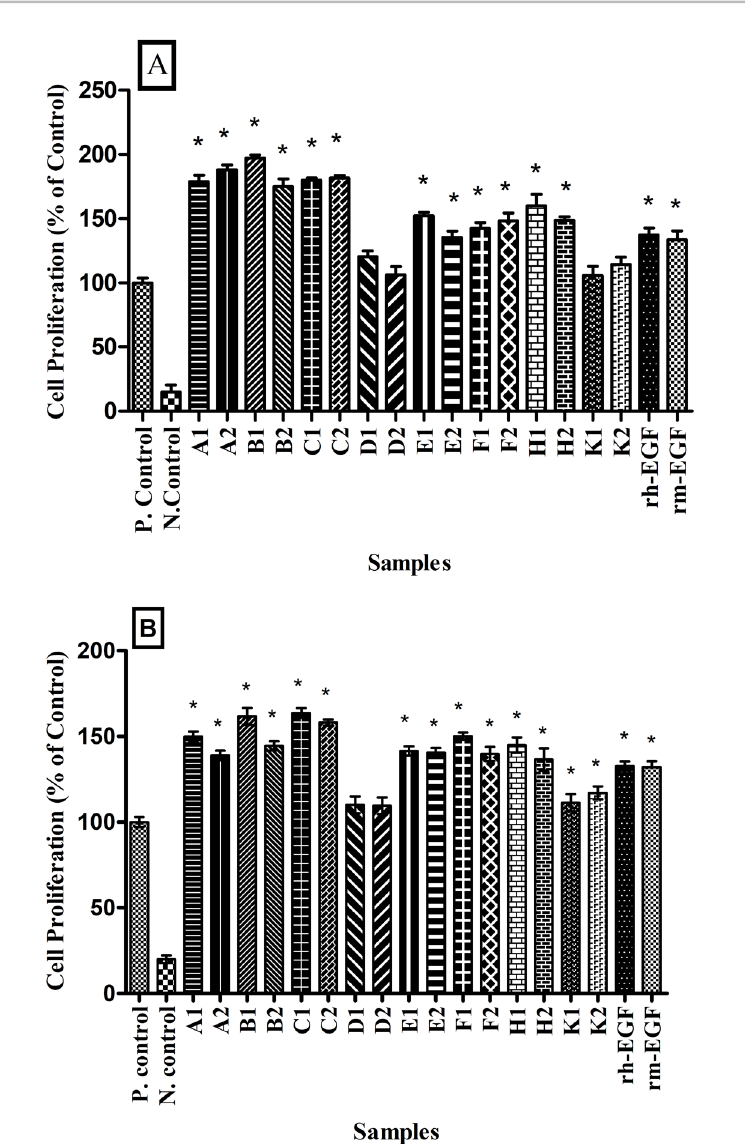
FIGURE 7 - BrdU cell proliferation results of NIH 3T3 (A) and HaCaT (B) cell lines (n=3). Positive control (non-treated) group includes NIH 3T3 (A) and HaCaT (B) cells consecutively. The cell proliferation ratio of the positive control group was accepted as 100%. The negative control (non-treated) group does not include cells. Values are the mean of triplicate determination (n = 3) ± standard deviation and statistically significant at * p<